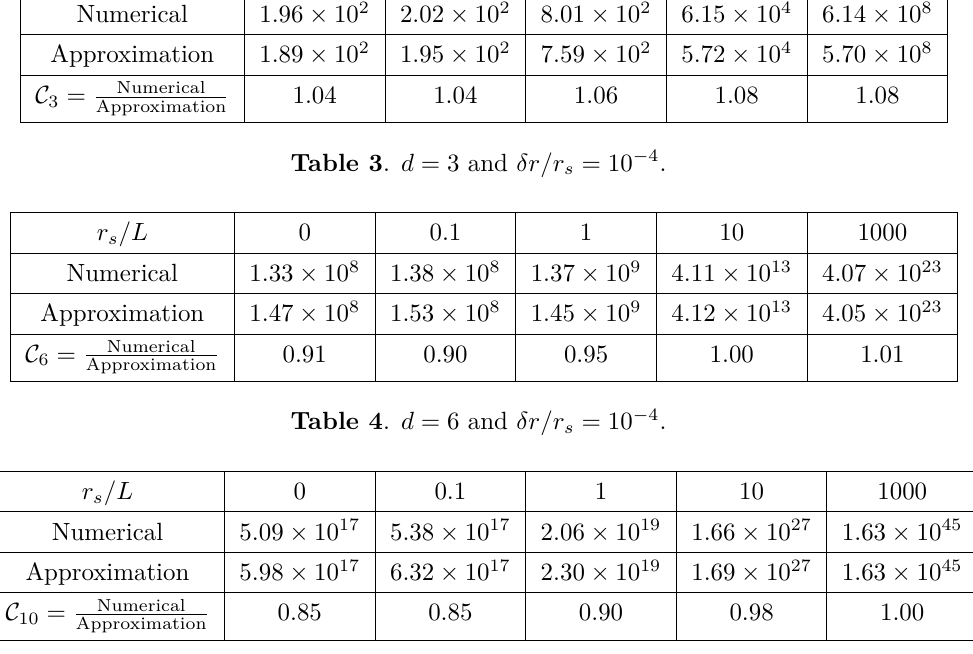
Table 5 . d = 10 and δr/r s = 10 − 4